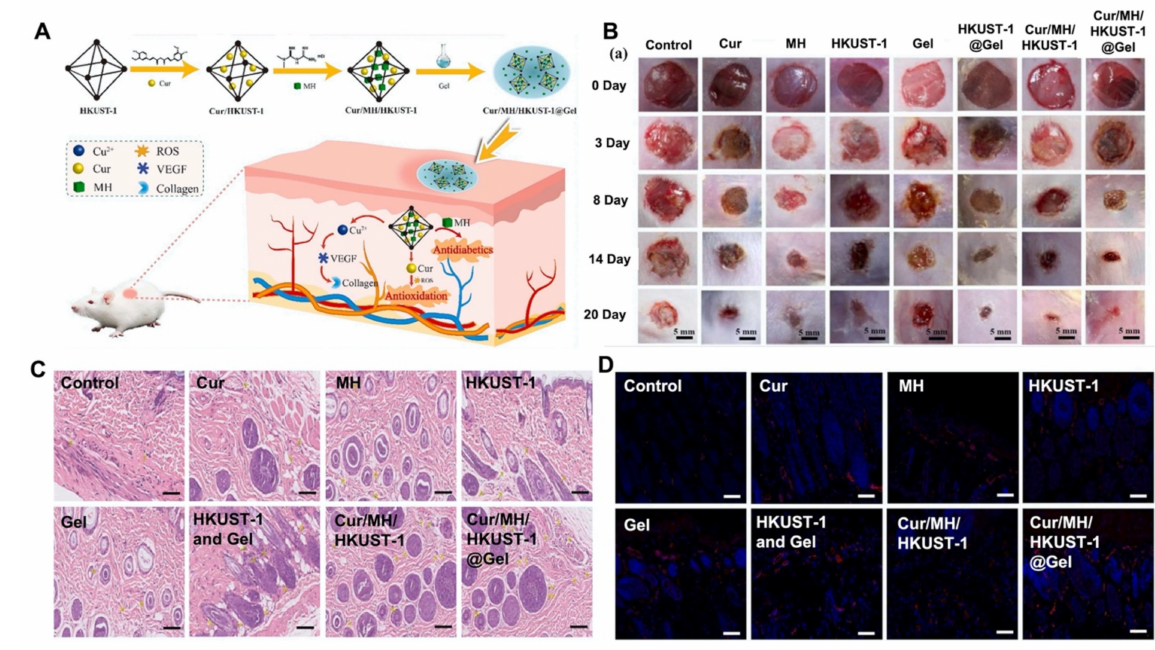
Figure 4. ( A ) Schematic representation of the fabrication of a drug releasing hydrogel. Metformin hydrochloride (MH) and curcumin (Cur) incorporated in a copper-based hybrid composite hy- drogel Cur/MH/HKUST-1@Gel for murine diabetic wound healing. ( B ) Representative wound closure images of diabetic mice treated with Cur, MH, HKUST-1, Gel, Cur/MH/HKUST-1, and Cur/MH/HKUST-1@Gel for 20 days. ( C ) H&E staining images exhibiting tissue granulation and ( D ) Immunofluorescence staining images of CD31 to show neovascularization in mice skin tissue upon treatment with different groups. Reproduced with permission [127]. Copyright 2022